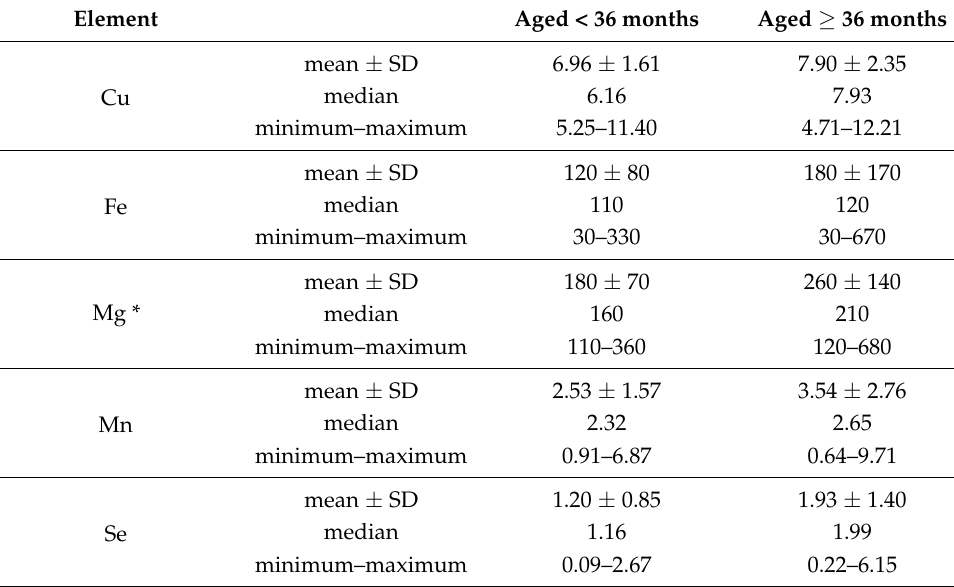
Table 6. Differences detected between the classes of age (mg · kg − 1